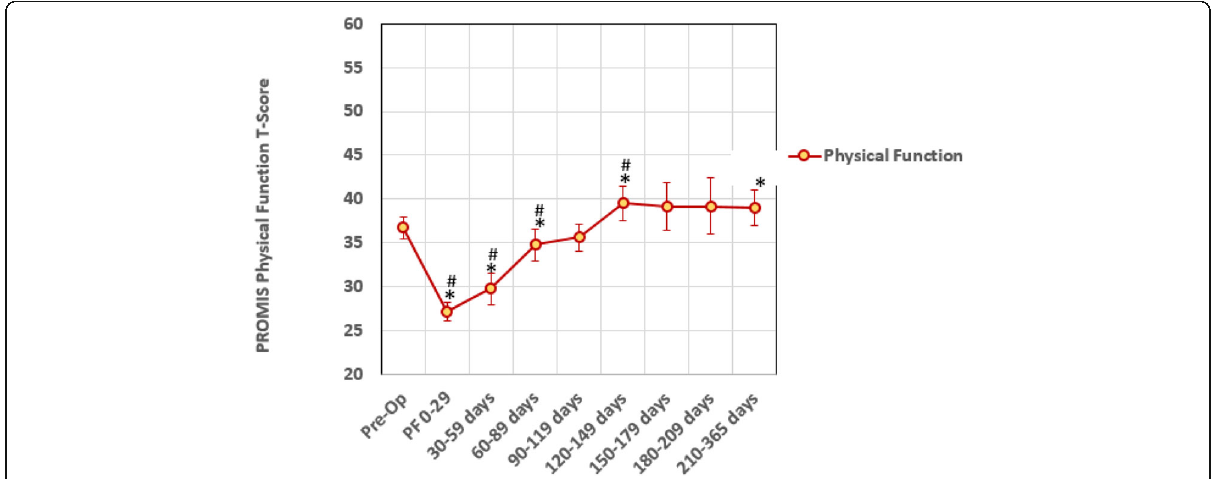
Fig. 1 Recovery roadmap for PROMIS physical function T-scores for ankle arthrodesis patients. A lower T-score indicates improvement in symptoms. Error bars are the standard error of the mean for each time point. * = significance difference ( p < 0.05) from pre-op to follow up time interval. # = significant difference( p < 0.05) from previous time point. Significance was determined using linear mixed model analysis ( n =